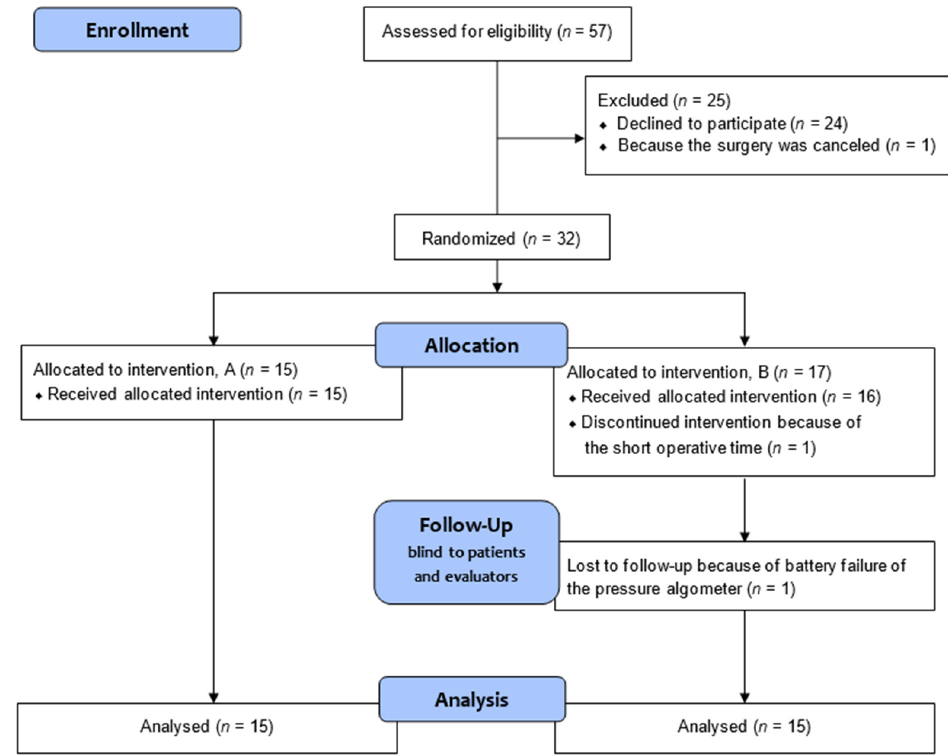
Figure 2. CONSORT flow diagram of subject progress through the study. Informed consent for the study was obtained from 33 patients. One patient was excluded, as the operation was canceled; 32 patients were randomly assigned into fentanyl sufficient (group A) and fentanyl sparing (group B) dose groups, and only the anesthesia staff were aware of the assignment and performed the procedure. The patient, and the evaluator of the numeric rating scale score and pressure pain threshold were not informed of the assignment. One subject was excluded from group B owing to the short operative time. Another subject was excluded because the pressure pain threshold could not be measured after surgery due to a malfunction of the pressure algometer. Fifteen subjects in each group were analyzed. Table 1. Patient